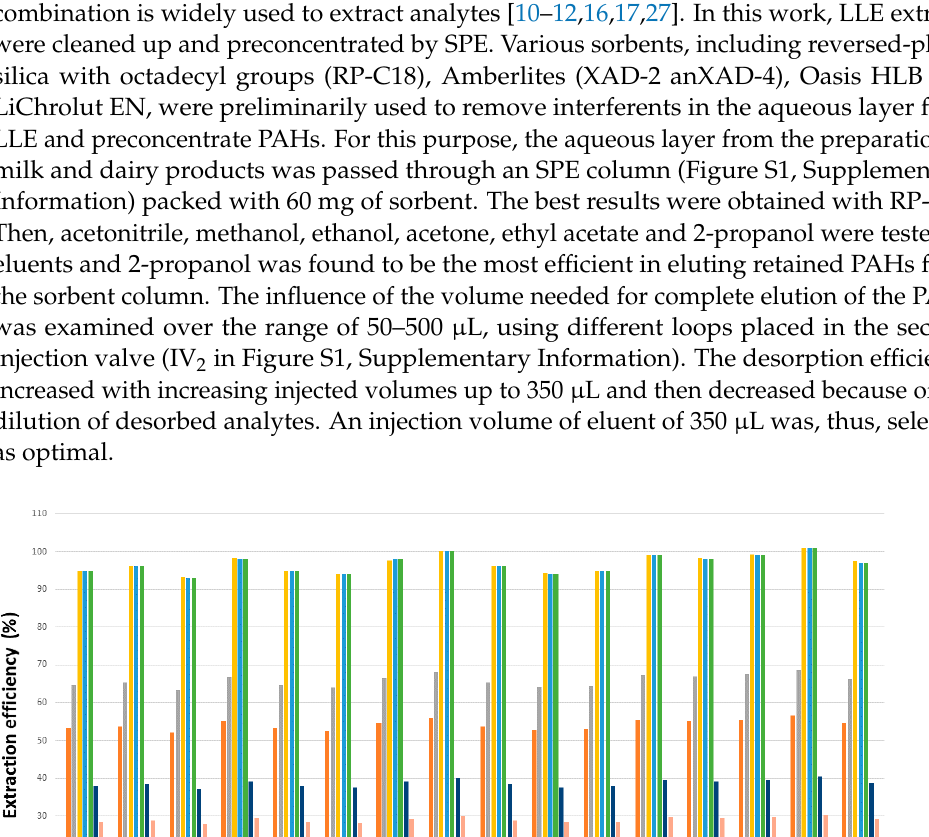
Figure 3. Influence of the volume of n -hexane on the extraction of polycyclic aromatic hydrocarbons from butter and margarine.